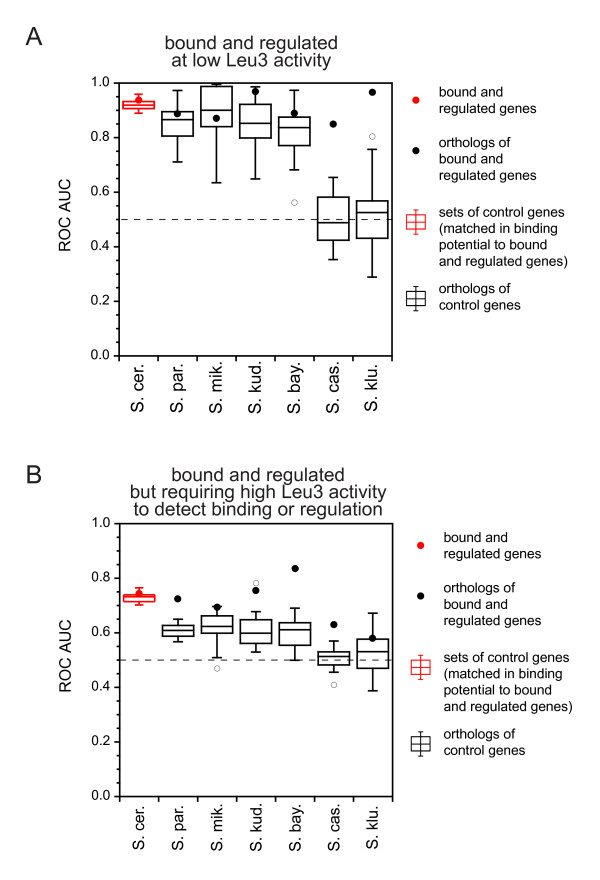
Bound and regulated genes are more conserved in predicted binding potential than control genes of comparable binding potential. (A) Predicted binding potential for the 600 bp upstream of every protein-coding gene in S. cerevisiae was calculated using GOMER and a Leu3 position weight matrix, and the calculations were repeated for the 600 bp upstream of all orthologous genes from six other species (Methods). The red circle shows the ROC AUC value obtained from comparing the 9 S. cerevisiae genes that were identified as bound and regulated in low activity experiments with all other genes in the same genome; the black circles are the values calculated for orthologous genes in six related species. The red box plot show the distribution of ROC AUC values obtained from 20 sets of 9 control sequences that were selected to closely approximate the predicted binding potential of the bound and regulated genes (Methods). The black box plots are comparable but are calculated using the orthologs of the genes chosen from S. cerevisiae; the open circles are the box plot outliers. For both experimental and control genes, if an ortholog was undefined in a genome, that gene was simply omitted from the analysis for that genome. Note that the predicted binding potential of bound and regulated genes is maintained in the distantly related species S. castelli and S. kluyveri to a much greater extent than control sequences. (B) Same as panel A except the genes defined as bound and regulated required high Leu3 activity for their detection in either the ChIP or expression assays, or both. There are 45 such genes, 31 of which required high Leu3 activity for detection in both assays. The remainder were detected at low activity in one of the assays (Fig. 3).